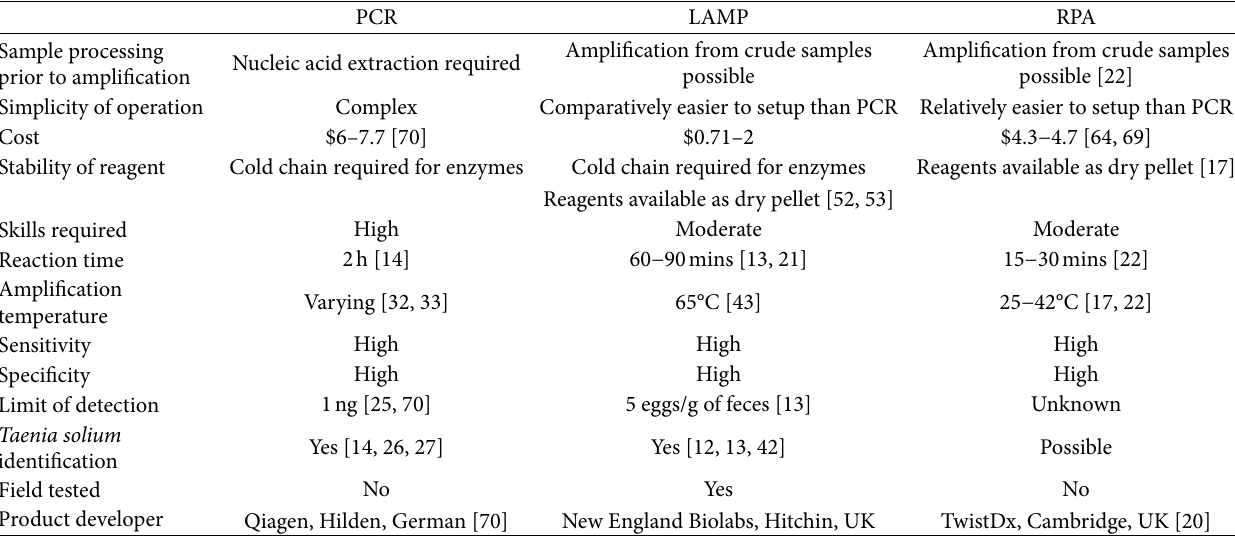
Table 5: Comparison between established PCR and most common isothermal amplification